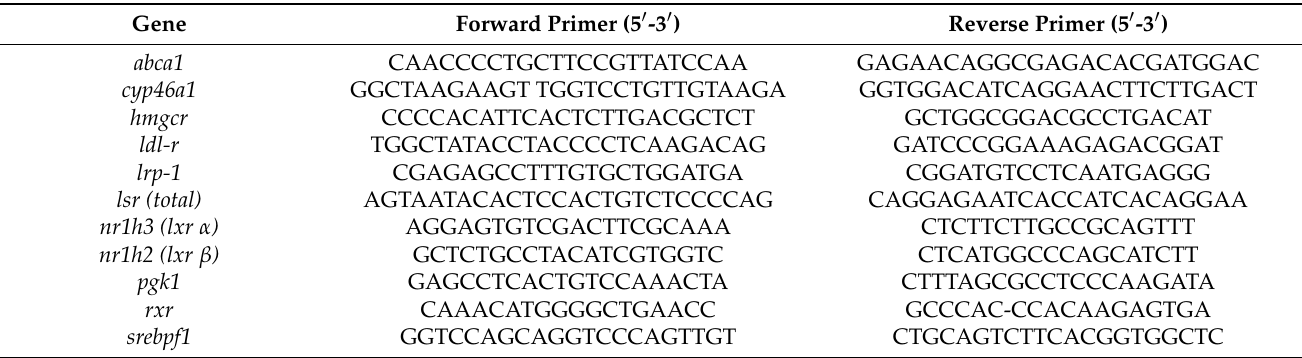
Table 1. Sequence of primers used for